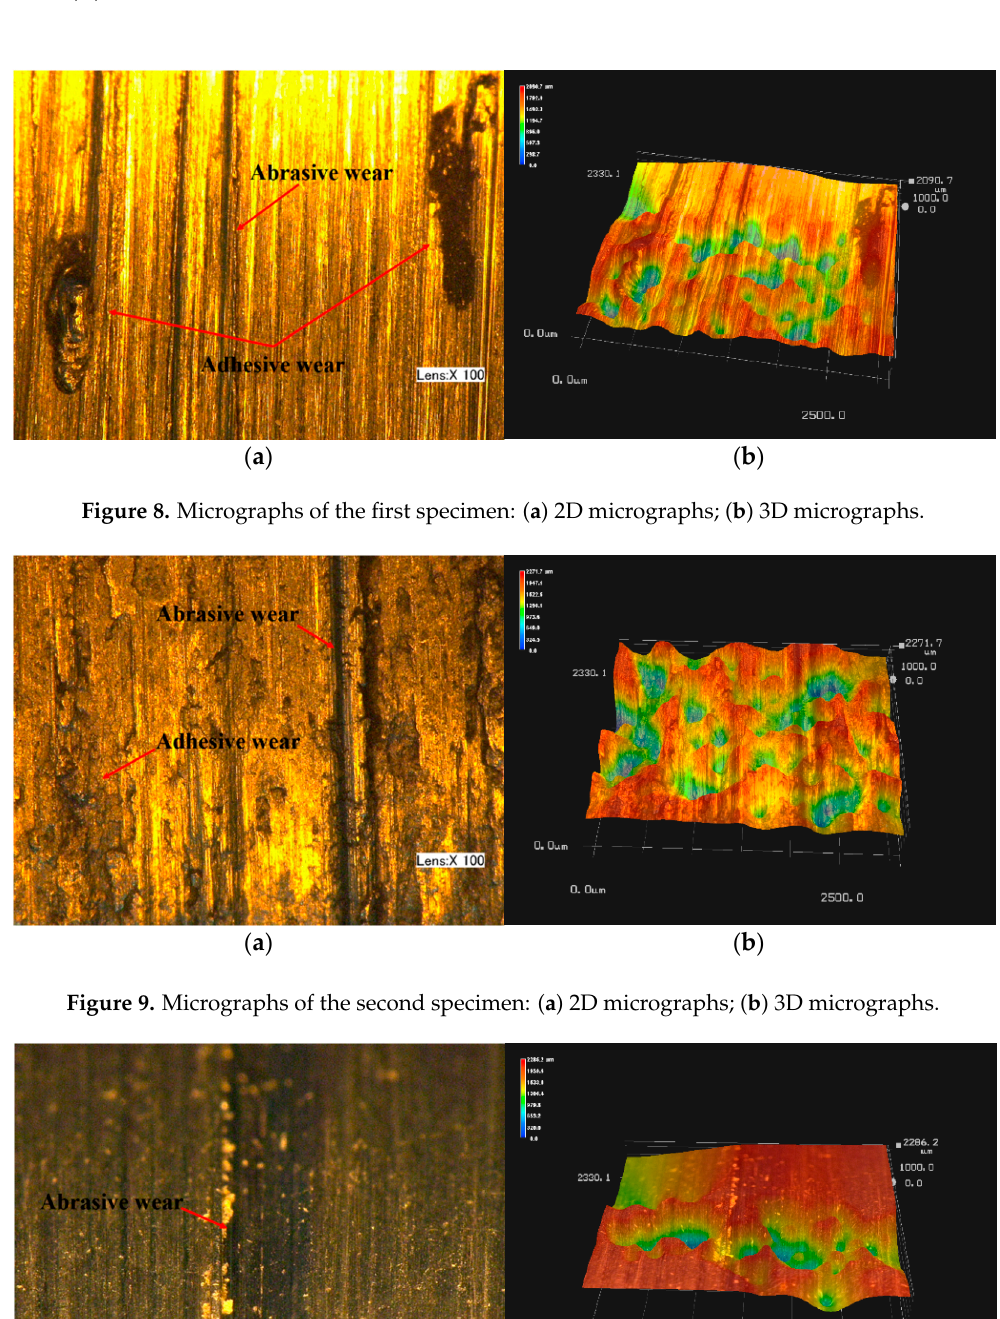
Figure 11. Micrographs of the fourth specimen: ( a ) 2D micrographs; ( b ) 3D micrographs. 4. Discussion Influenced by various kinds of factors, such as loads, rotational speed, and lubrication condition, the wear process of low rotational speed pin connections is long and complicated. However, the wear forms of pin connections can be distinguished by an acoustic emission technique in this experiment. Comparing the results of the AE signals and the results of the micrographs, it can be found when only abrasive wear occurs on the surface of pins (such as on the third and the forth specimens), the signal strength value is low (their values are 9.475 mVs and 19.08 mVs respectively). By contrast, when adhesive wear occurs on the surface of pins (such as the first and the second specimens), the signal strength value is much larger than in abrasive wear (in the first and second specimens, their